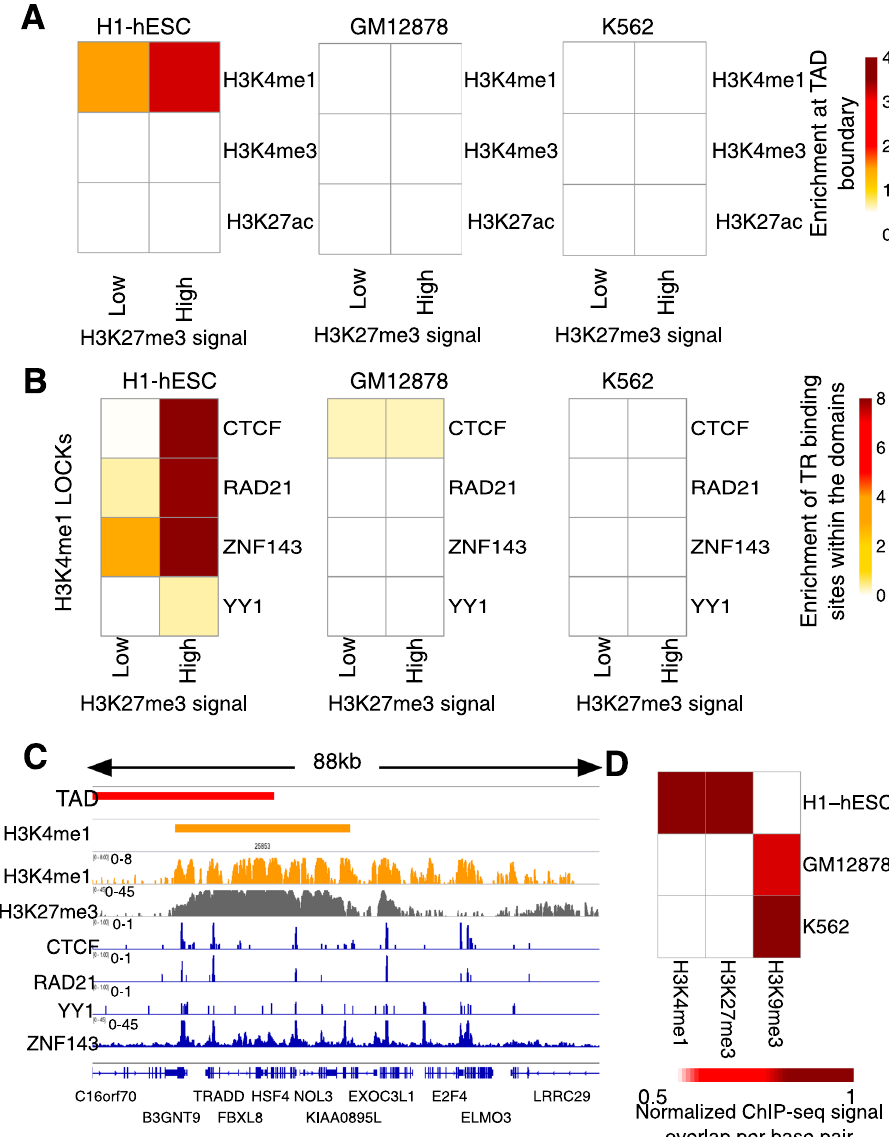
Fig. 5 Bivalent LOCKs in primitive cells are enriched at TAD boundaries and bound by regulators of chromatin interactions. A Enrichment of LOCKs of active marks with low or high H3K27me3 ChIP-seq signal at TAD boundaries de fi ned within H1-hESC, GM12878 or K562 cell types ( − log10(FDR)). B Enrichment of regulators of chromatin interactions (CTCF, RAD21, ZNF143 and YY1) in H3K4me1 LOCKs with low or high H3K27me3 ChIP-seq signal in H1-hESC, GM12878 and K562 cell types ( − log10(FDR)). C Case example of a bivalent LOCK at a TAD boundary in H1-hESC cells on the chromosome